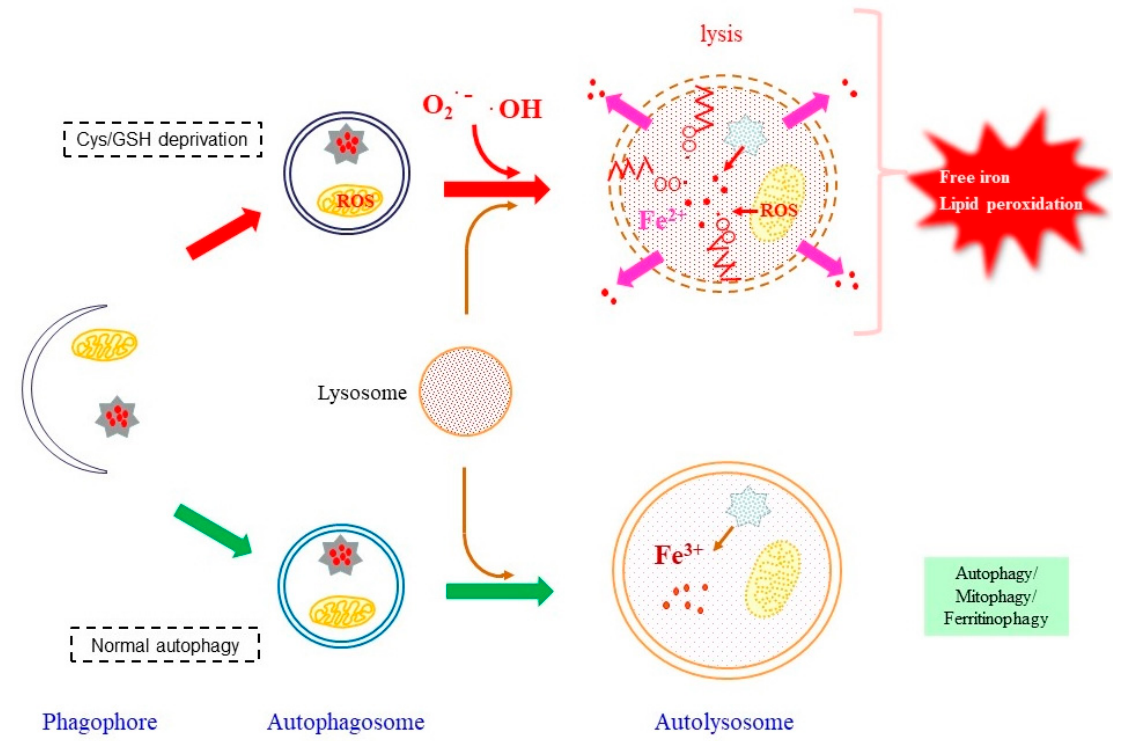
Figure 2. A role of ferritinophagy in releasing free iron. In normal ferritinophagy, free iron is released from ferritin but remains in the autolysosomes, which does not cause deteriorating effects as schematized at the bottom. Under ferroptotic conditions, the produced ROS causes lipid peroxidation. The presence of peroxidized lipids and free iron would make autolysosome membrane vulnerable, leading to the destruction of the vesicular structure.